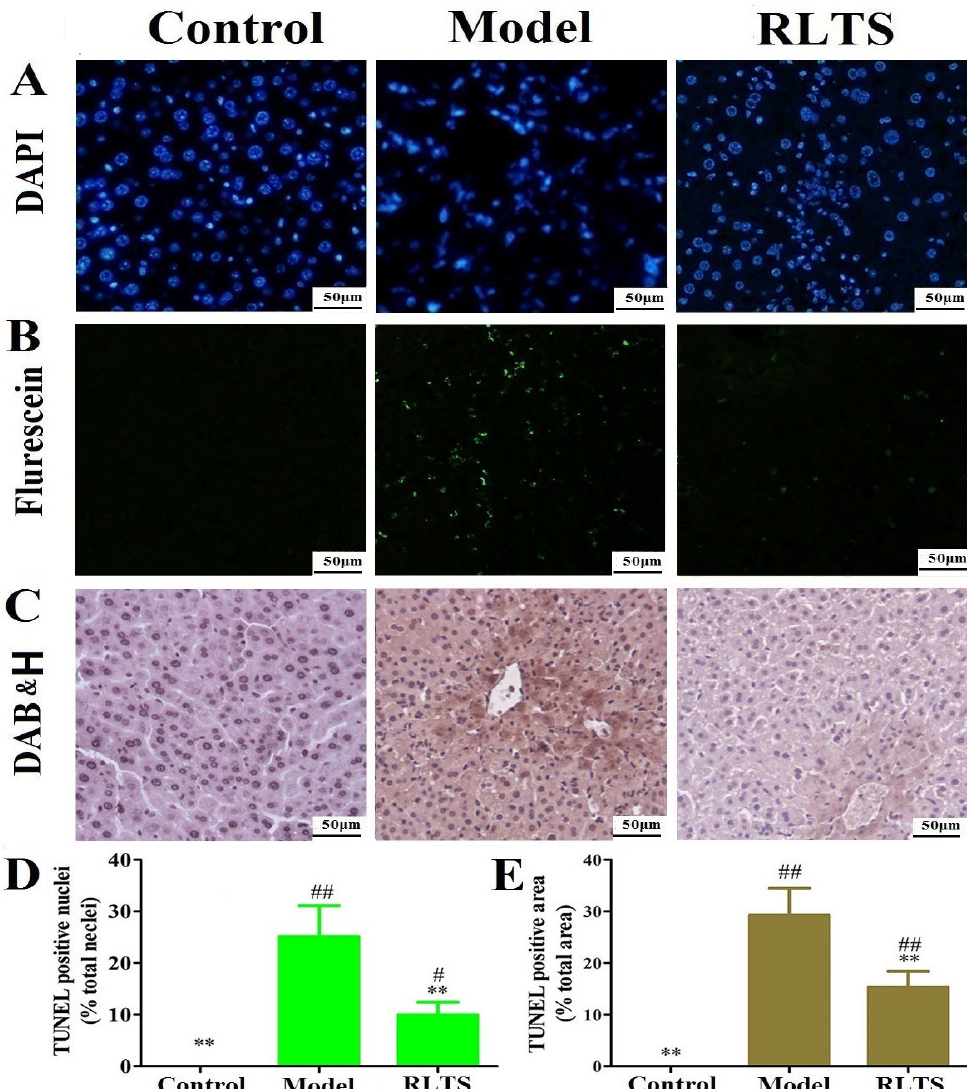
Figure 3. Representative micrographs of DAPI stained nuclei ( A ), TUNEL fluorescent images ( B ) and DAB&H stained images ( C ) in normal control, model and RLTS (300 mg/kg) groups (magnification, 400×). Statistic analysis of TUNEL fluorescent images ( D ) and DAB&H dyeing images ( E ). Values are expressed as mean ± SD ( n = 4). ** p < 0.01 vs. model group; ## p < 0.01, # p < 0.05 vs. normal